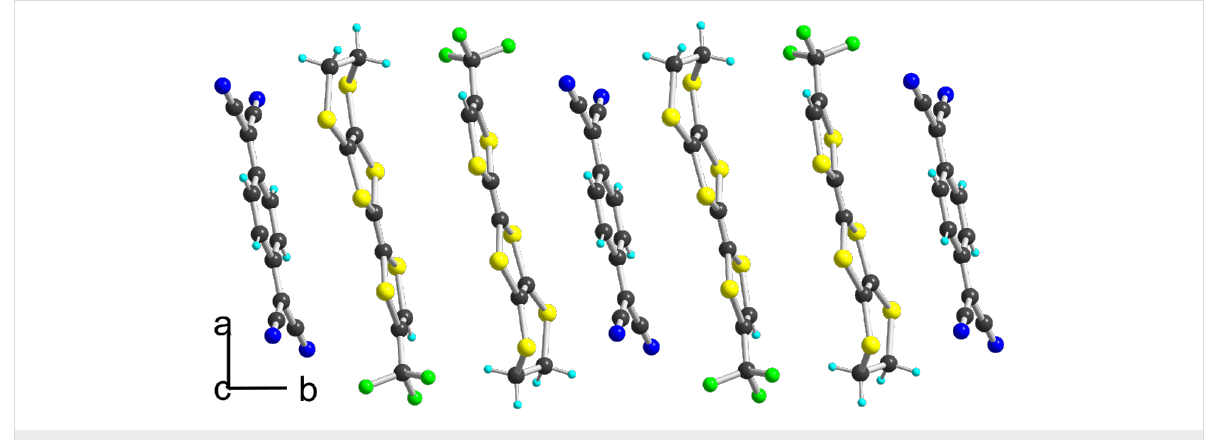
Figure 7: A view of the alternated stacks along the b axis in ( 1c ) 2 (TCNQ).